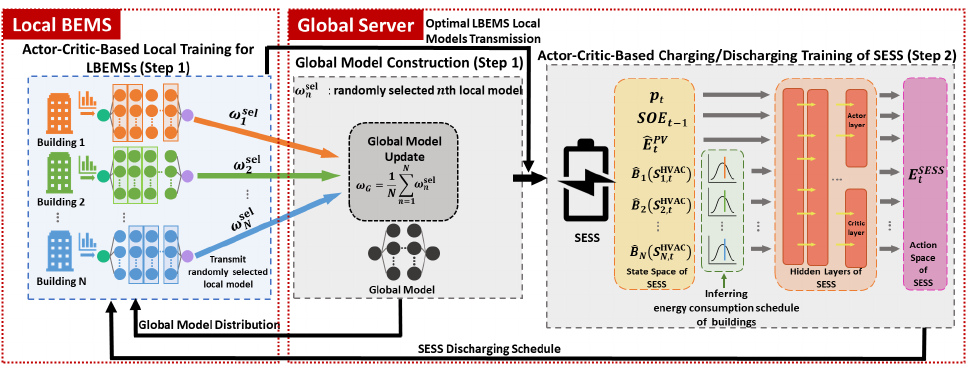
Figure 2. Training process for the proposed FRL-based energy management of smart buildings connected to a